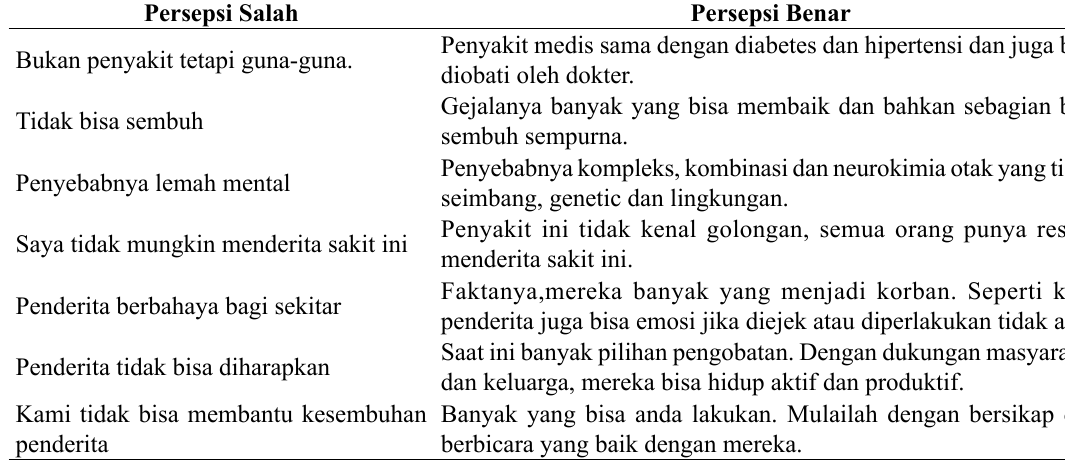
Tabel 7. Persepsi kepada penderita gangguan